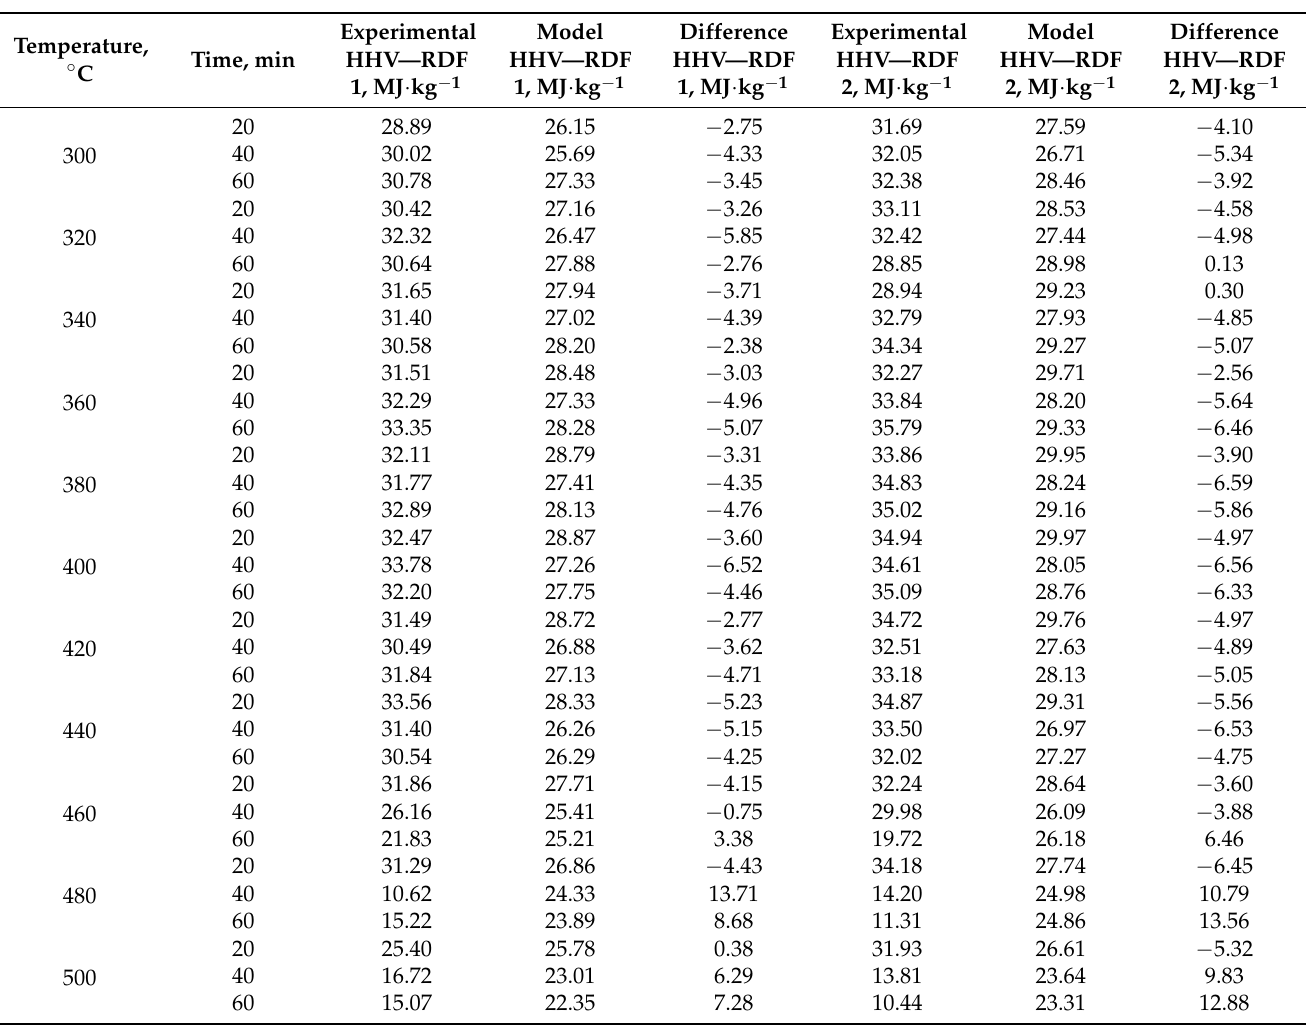
Table A1. Comparison of experimental and model results of HHV of RDF 1 and RDF2 blends, column “Difference HHV” was calculated as the difference between model and experimental